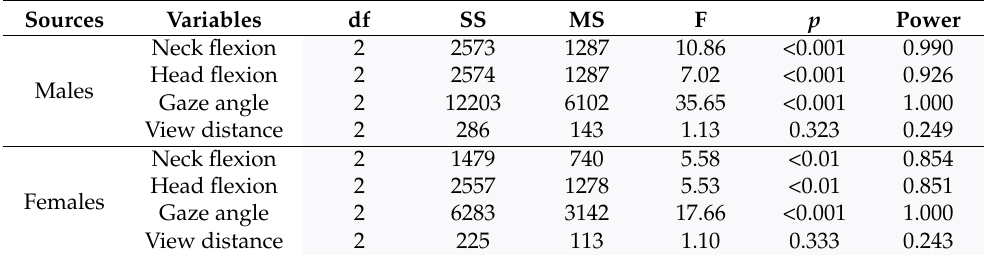
Table 5. One-way ANOVA results for each gender.